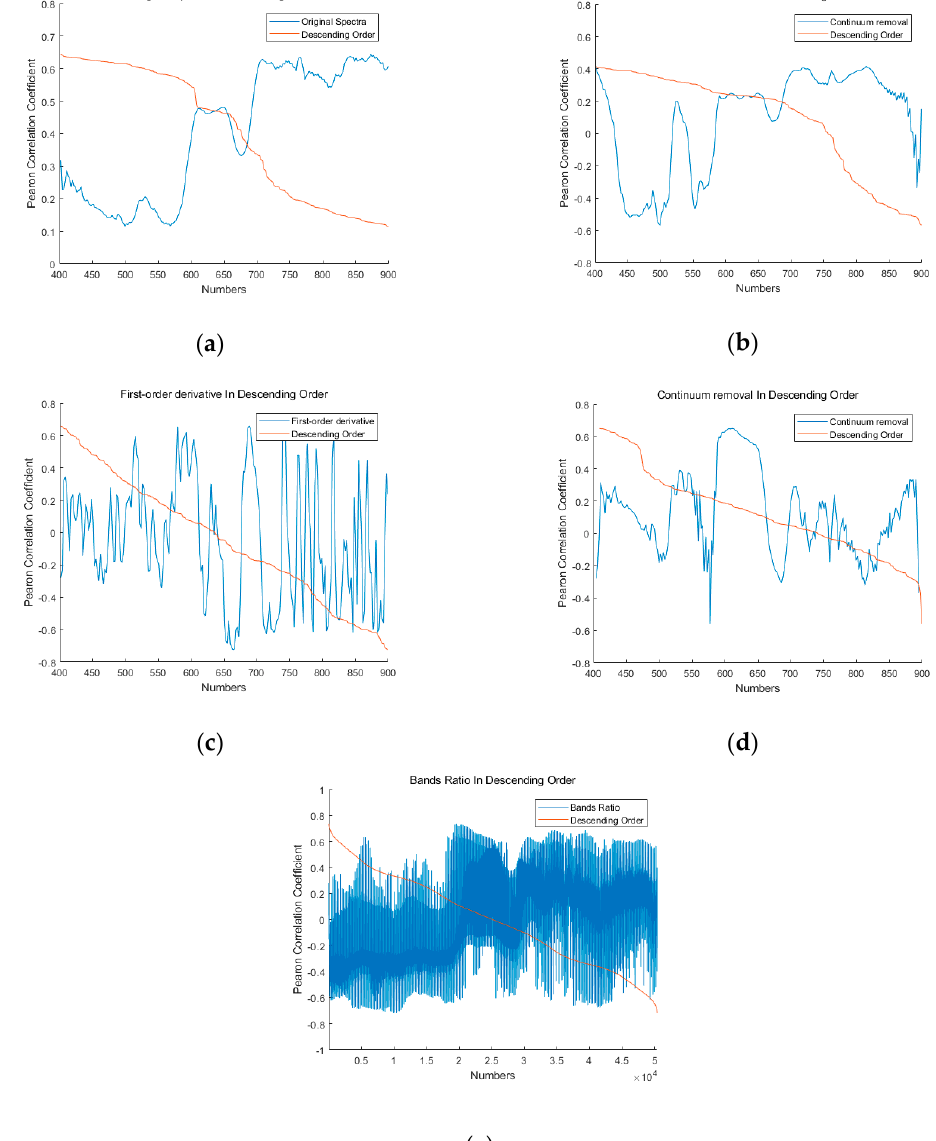
Figure 6. Pearson’s correlation coefficients with suspended solids concentration: ( a ) Original spectra. ( b ) Max-min normalization result. ( c ) First-order derivative result. ( d ) Continuum removal result. ( e ) Band ratio result.